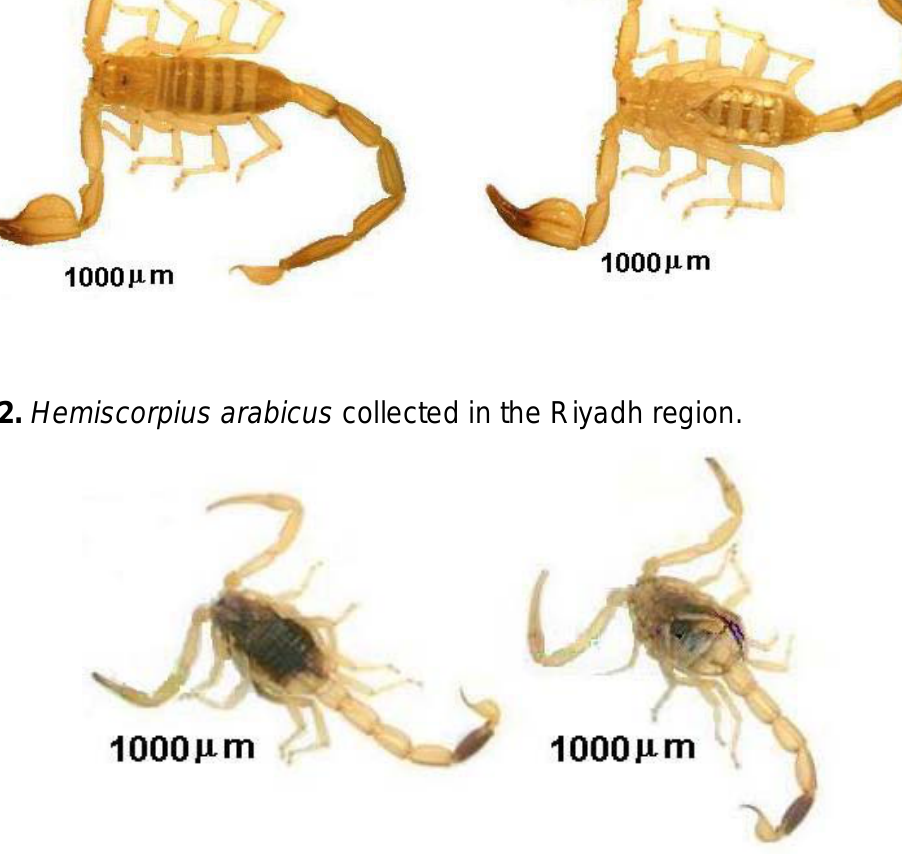
Figure 3. Leiurus quinquestriatus collected in the Riyadh